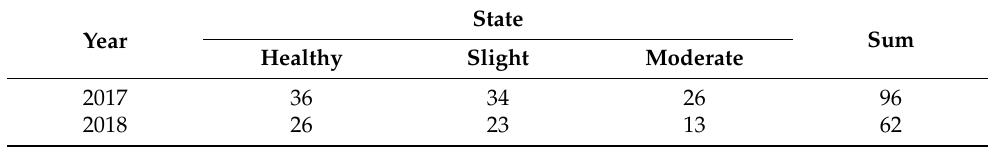
Table 1. Summary of field measurement activities for 2016–2017 and 2017–2018.